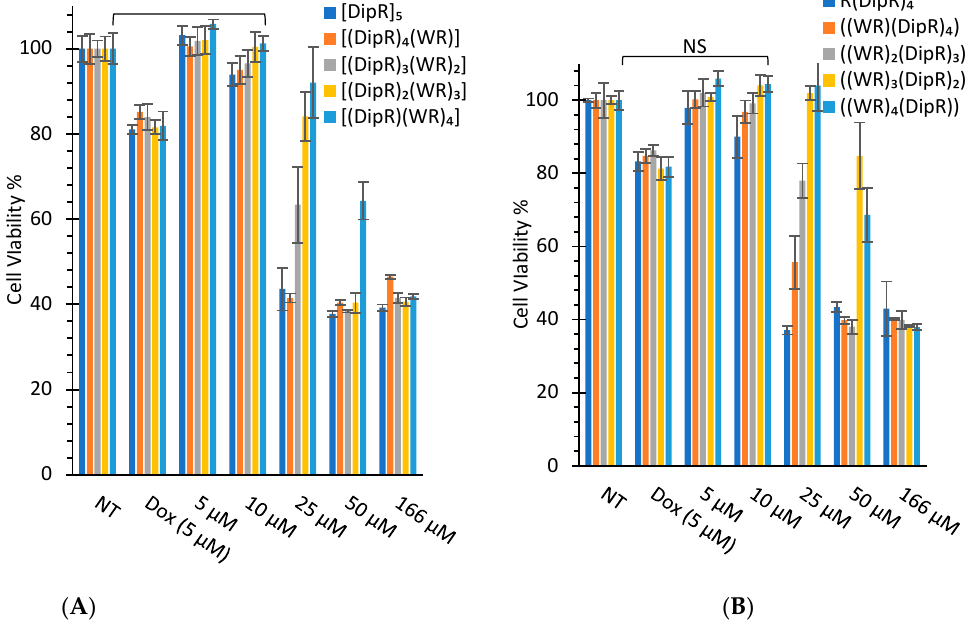
Figure 3. Cytotoxicity study of cyclic ( A , C , E , G ) and linear ( B , D , F , H ) peptides in CCRF-CEM cells and SK-OV-3 after 24 h and 72 h incubation. Results are mean ± SD (n = 3) (*** p < 0.001 treatment vs. no treatment (NT)).